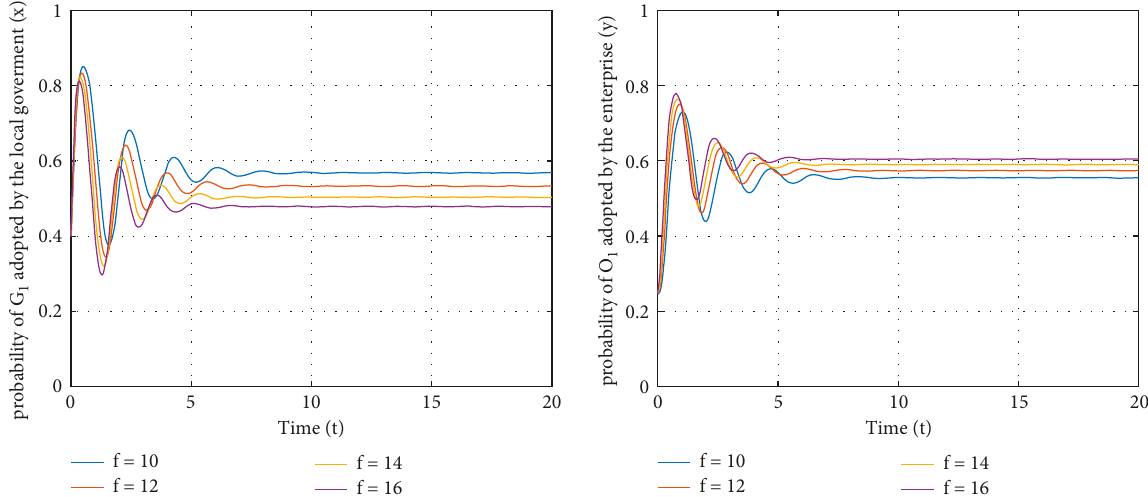
Figure 11: The impact of raising the upper limit of f on local government and